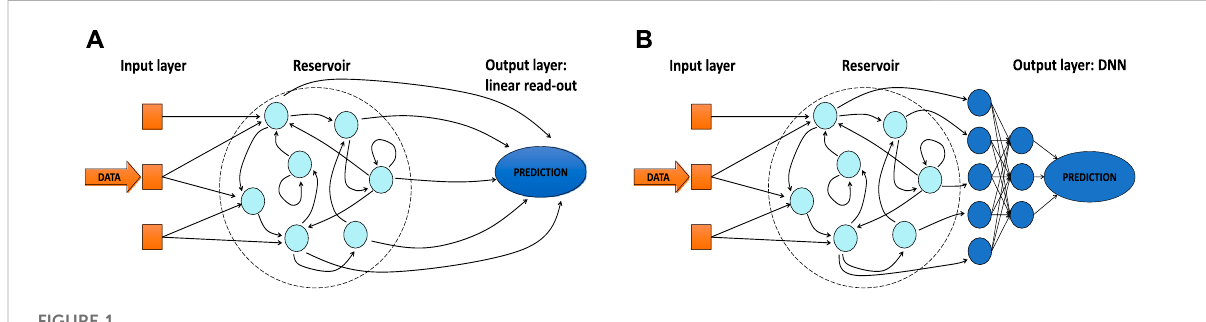
FIGURE 1 Simpli fi ed representation of a generic reservoir computing system, with the input layer, reservoir and linear read-out as output layer (A) . Simpli fi ed representation of the network that uses a reservoir as preprocessor. In the output layer, we have replaced the linear read-out layer with a deep neural network (DNN) in order to make predictions (B)